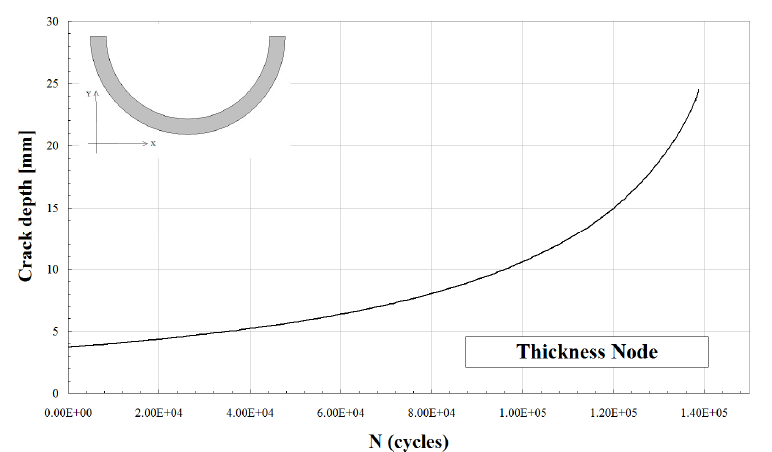
Figure 27: Number of cycles to achieve through-the-thickness crack in casing.